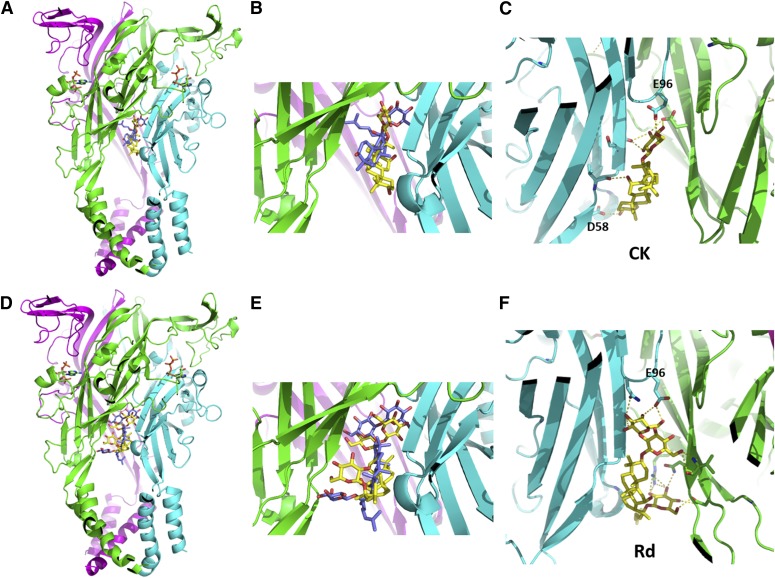
Molecular model of hP2X4 with CK and Rd docked into a predicted central vestibule binding site. (A) Representation of a homology model of trimeric hP2X4 in the open (ATP-bound) state with ginsenoside CK docked in the central vestibular region. Each subunit chain is differentially colored (green, cyan, and magenta). (B) A zoomed-in view of the binding site to compare CK pose docked to hP2X4 (yellow) to CK pose docked to hP2X7 (purple). (C) A rotated view of the CK binding site from the inside of the cavity facing outward (rotation of 180°). Polar contacts are highlighted between CK and β-sheets lining the lower body region. (D) Trimeric hP2X4 model with ginsenoside Rd docked into the central vestibule binding site. (E) A zoomed-in view of the binding site to compare Rd pose docked to hP2X4 (yellow) to Rd pose docked to hP2X7 (purple). (F) Same rotated view of the Rd binding site from the inside of the cavity facing outwards (rotation of 180°). Polar contacts are highlighted between Rd and β-sheets lining the lower body region and E96 in the internal loop region. Ligands and side chains are represented as sticks with all hydrogen atoms omitted for clarity. Images were generated in Pymol.